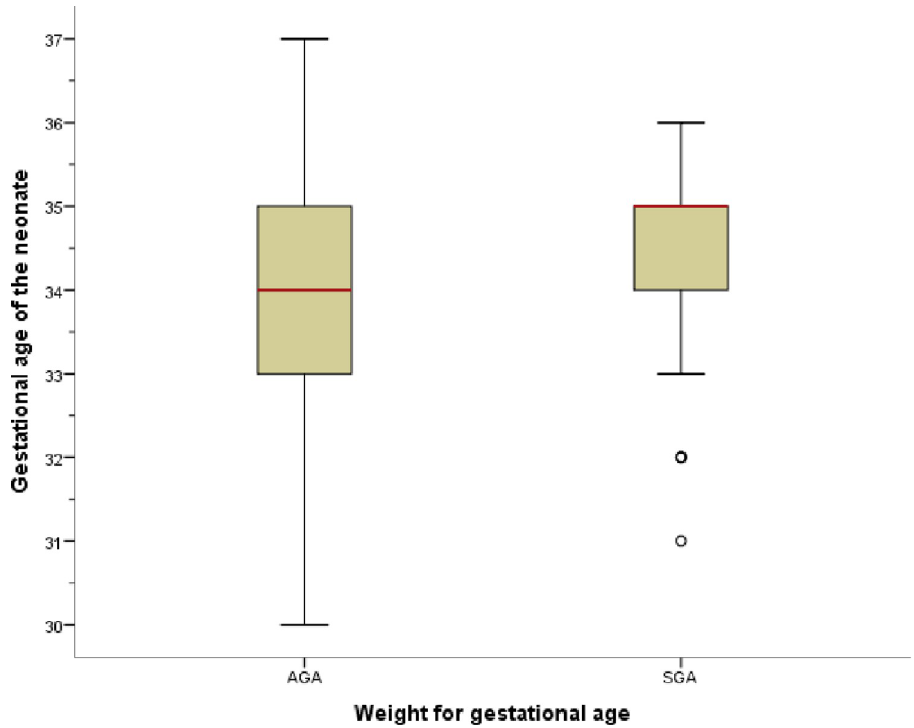
Fig 4. Box plot of birth weight of AGA and SGA neonates admitted to the neonatal ICU.